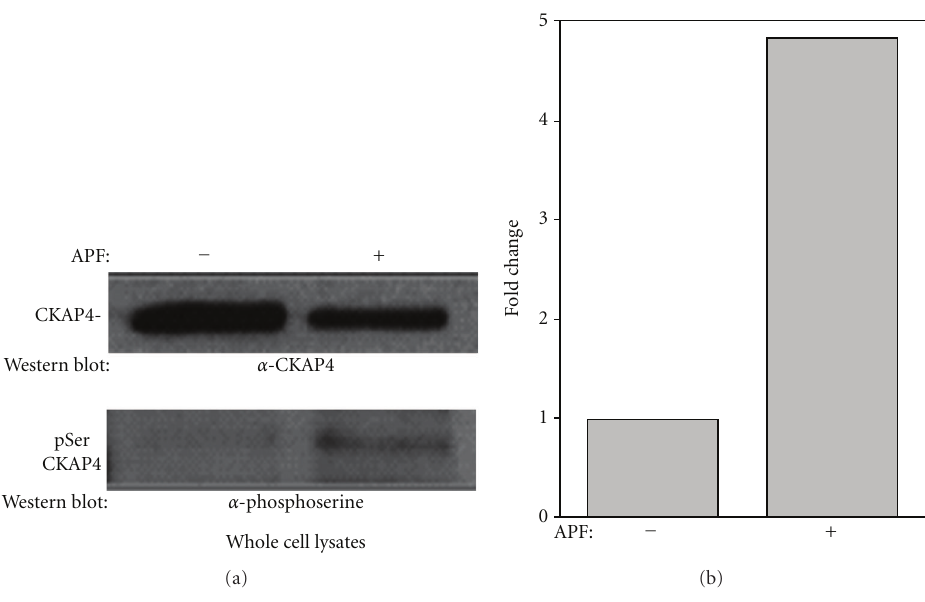
Figure 4: APF induces serine phosphorylation of CKAP4 . (a) APF treatment induces a significant increase in serine phosphorylation of CKAP4 as demonstrated by immunoprecipitation of CKAP4 followed immunoblotting to detect phosphoserine. Whole cell lysates (500 μ g) from HeLa cells treated with 20nM APF or serum-starved controls were immunoprecipitated with CKAP4 antibody (Alexis) overnight at 4 ◦ C. Samples were then bound to Protein A, washed (4X with RIPA/Empigen bu ff er), eluted (4X LDS sample bu ff er; Invitrogen), boiled at 95 ◦ C for 5min and resolved on a 4–12% Bis-Tris gel and transferred to a nitrocellulose membrane under reducing conditions. Western Blot analysis for pSer detected phospho-serine using primary (Invitrogen and secondary antibodies (goat anti-rabbit HRP-labeled antibody; Pierce)) developed with Enhanced Chemiluminescence reagent (Pierce) and exposed to film. The membrane was stripped with Restore Stripping Bu ff er (Pierce) and reprobed for CKAP4 (Alexis) to normalize the phosphoserine signal to the amount of immunoprecipitated CKAP4. (b) Densitometric analysis of the immunoreactive bands was done using ImageJ, and the ratios of phosphorylated to nonphosphorylated CKAP4 were